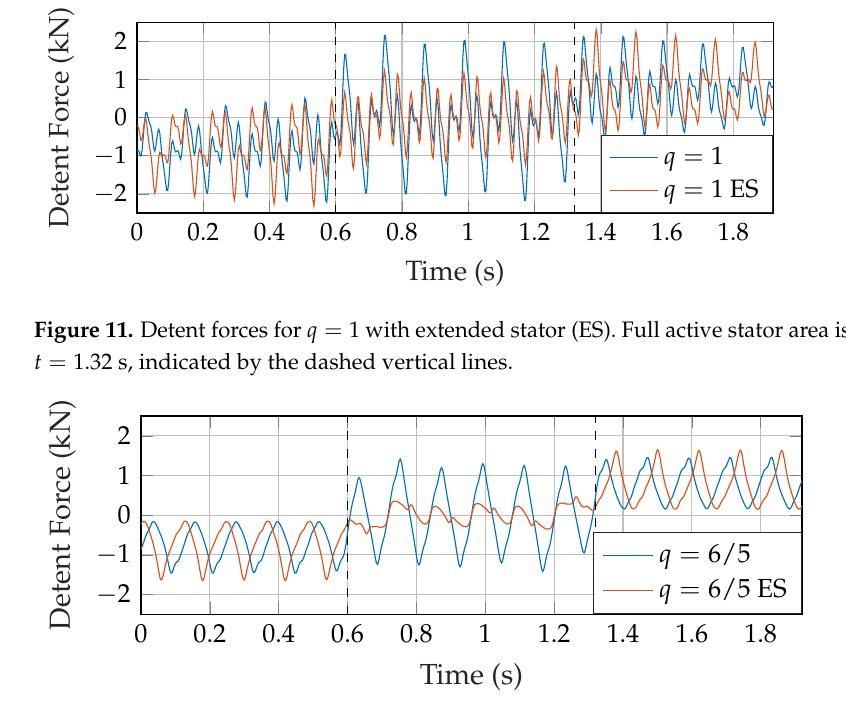
B q = 6/5 S q = 6/5 Figure 14. Phase voltages for q = 6 5 for both topologies. The stroke length allows for 50 % active stator area. Full stator overlap for buried (B) and surface (S) topologies is from t = 0.6 s to t = 1.32 s and t = 1.2 s, respectively, indicated by the dashed vertical lines. The different phases are indicated by different colors. 0 S ES Figure 15. Detent force for buried (B) and surface mounted (S) PMs with and without extended stator (ES). Full stator overlap for buried (B) and surface (S) topologies is from t = 0.6 s to t = 1.32 s and t = 1.2 s, respectively, indicated by the dashed vertical lines.